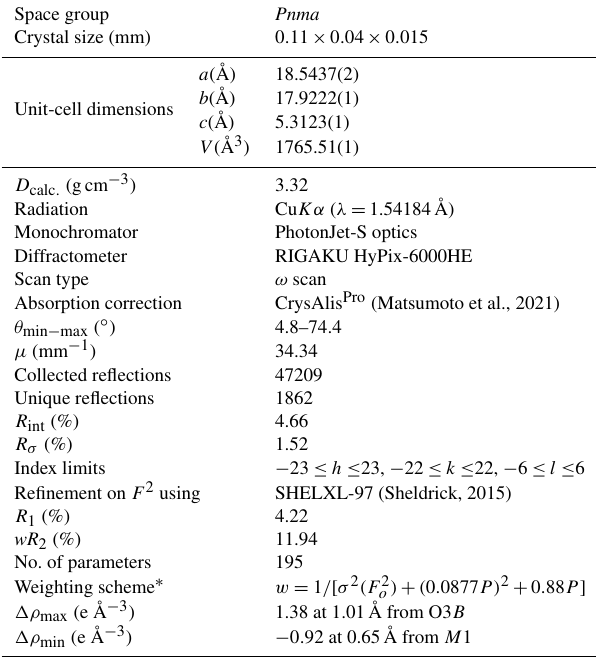
Table 3. Experimental details of the single-crystal X-ray diffraction analysis of ferro-ferri-holmquistite.